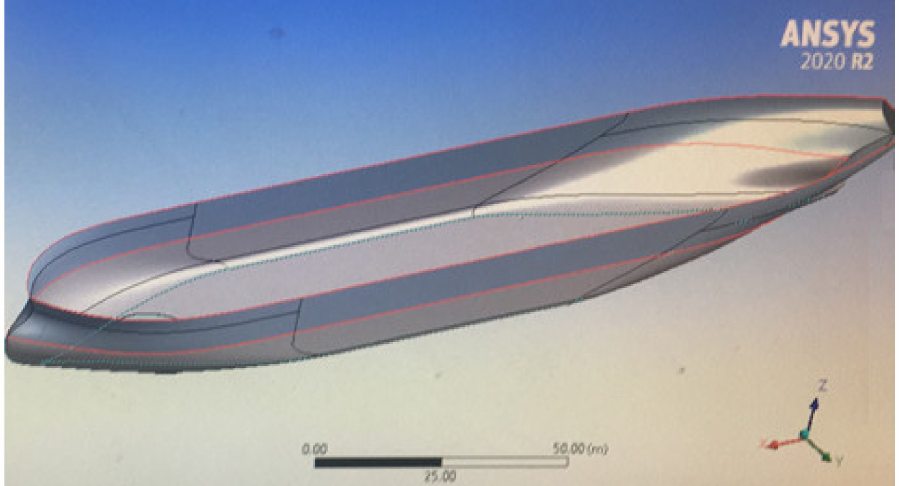
Figure 7. The model of a boat developed in ANSYS R2 2020